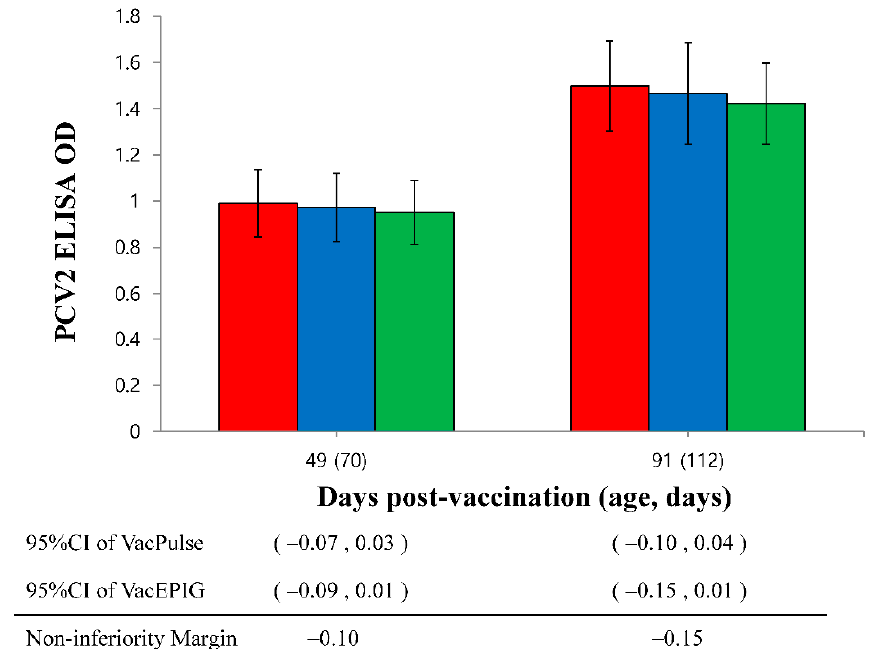
Figure 6. The lower bound of the 95% confidence intervals (CI) on the difference in porcine circovirus type 2 (PCV2) enzyme ‐ linked immunosorbent assay (ELISA) in the needle ‐ free device (VacPulse, ● ) group at 49 days and 91 days post ‐ vaccination (dpv) showed non ‐ inferiority to con ‐ ventional needle ‐ syringe (VacS, ● ) group. The lower bound of the 95%CI on the difference in